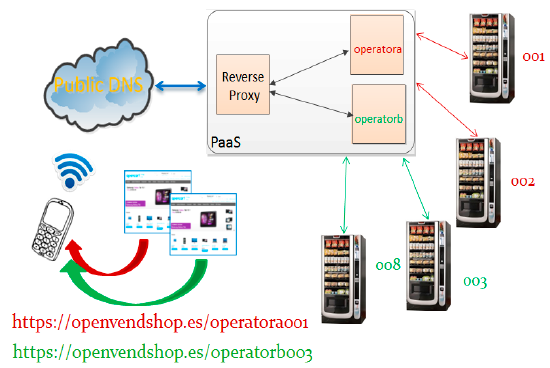
Figure 7. Access through domains.